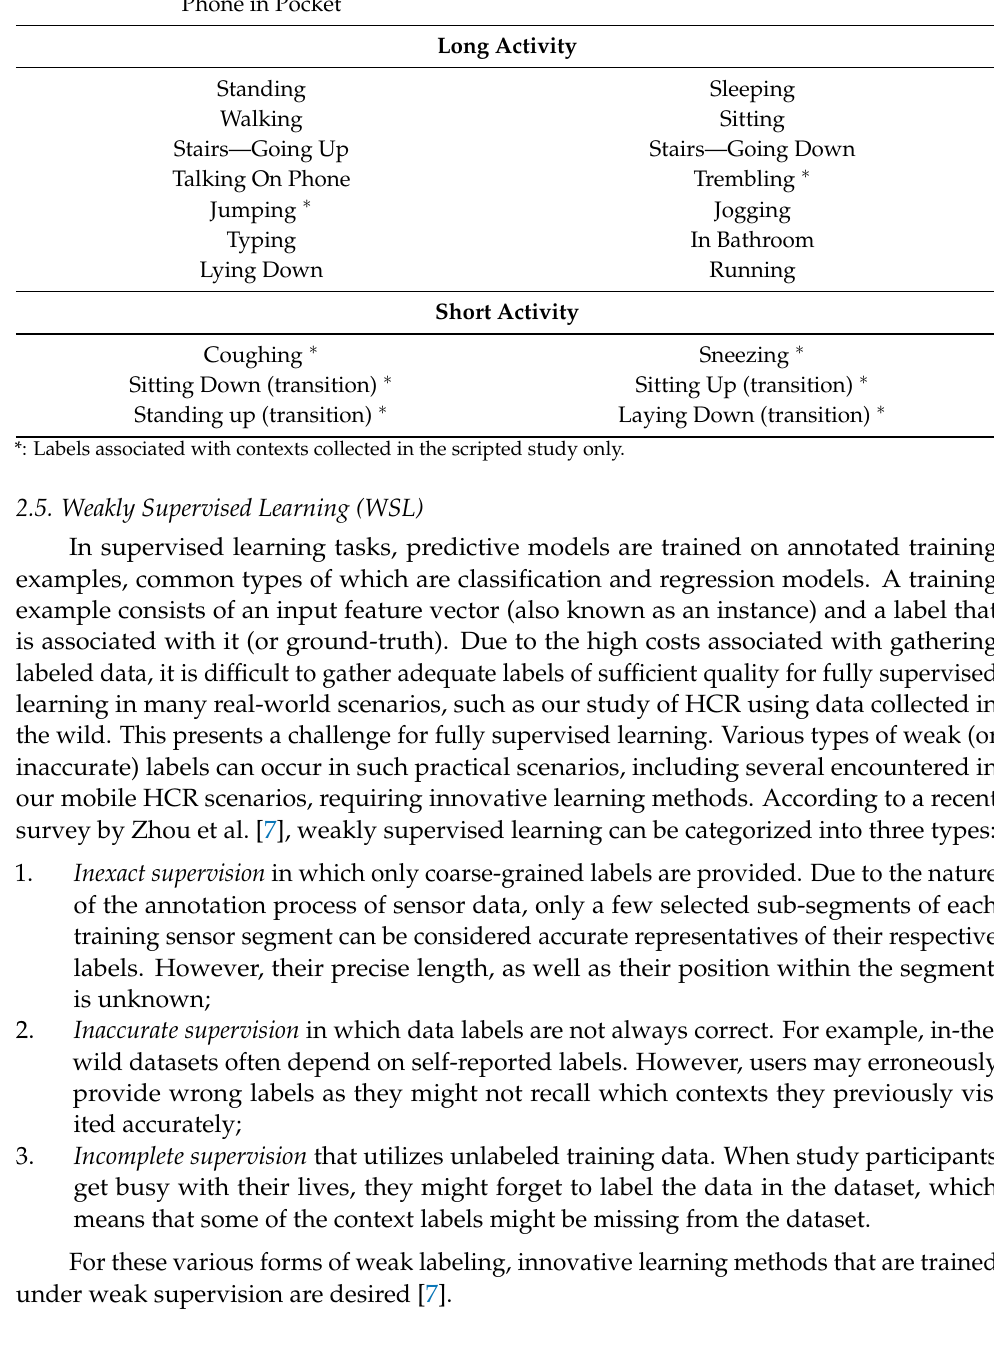
Table 2. Contexts for which data was obtained as part of our WASH Study Collected Contexts—split down into 25 binary labels. Phone Placement Phone in Hand Phone in Bag Phone in Table—Facing Up Phone in Table—Facing Down Phone in